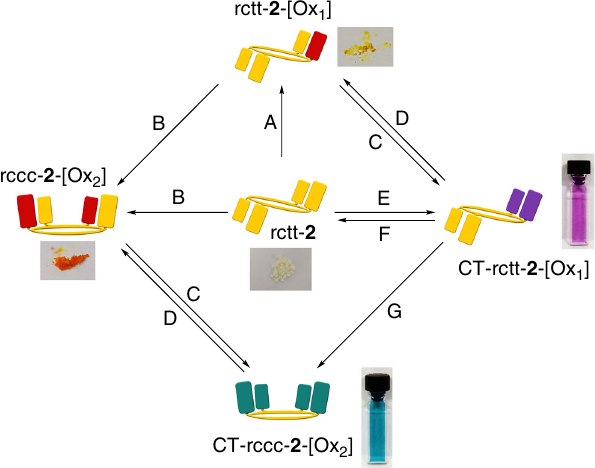
Fig. 5 Chemical switching manifold based on 2 . Conditions (CHCl 3 solution): A: 2,3-dichloro-5,6-dicyano-1,4-benzoquinone (1 eq.) or irradiation (285 nm); B: 2,3-dichloro-5,6-dicyano-1,4-benzoquinone (4 equiv.); C: tri fl uoroacetic acid; D: potassium carbonate or pyridine; E: tri fl uoroacetic acid/irradiation (285 nm); F: Zn metal/acetic acid/90°C;